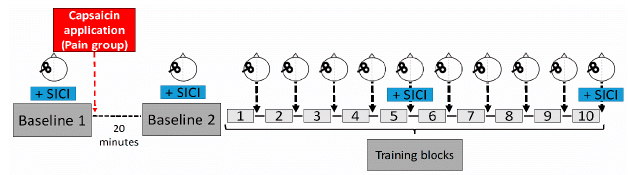
Figure 1. Experimental design. A subject performed ten training blocks of a novel motor task, and each block consisted of 15 successive trials. Corticospinal excitability was assessed using TMS at two baseline measurement periods (prior and after induction of pain (Pain group) or at similar time points (NoPain group), as well as after each training block. Short-interval cortical inhibition (SICI) was measured at the two baseline periods, and after blocks five and ten. The red arrow represents the time of capsaicin application for the Pain group. A wait period of 20 min was imposed on both groups between the two baseline measurements to enable pain levels to significantly increase.